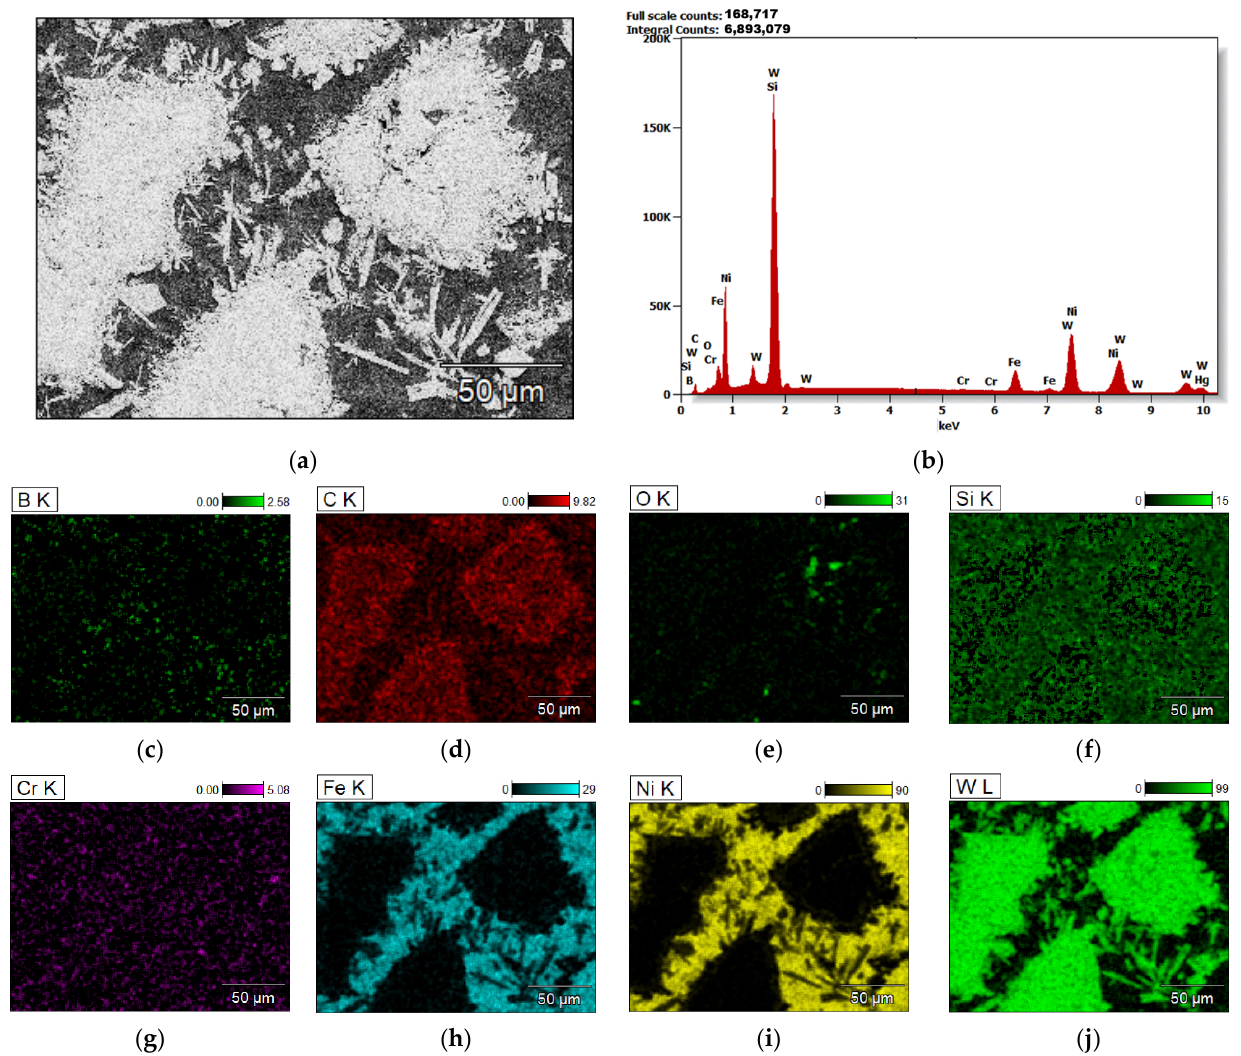
Figure 9. Elemental analysis of the middle zone of the surface layer of sample 4-PE ( a ) area under observation ( b ) X-radiation energy diagram of area under observation ( c – j ) elemental maps showing the position and amounts of elements present in the area under observation.